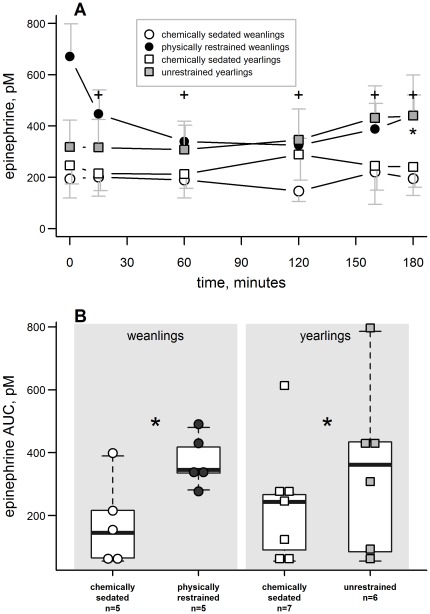
Epinephrine concentration in handling manipulated seals.
A) Epinephrine concentrations were generally stable during procedures except in physically restrained weanlings. These restrained seals had elevated epinephrine concentrations at the beginning of the procedures; “+” and “*” indicate significant difference from initial epinephrine concentration in physically restrained weanlings and unrestrained yearlings, respectively (pairwise post-hoc t-test, p<0.05). Error bars are standard errors. B) The lowest epinephrine AUC values occurred while study animals were chemically sedated in both weanlings (paired t = 2.9, p = 0.045) and yearlings (paired t = 2.9, p = 0.03). Central horizontal lines indicate the median of each group; whiskers extend to data points within 1.5 times the interquartile range from each box.